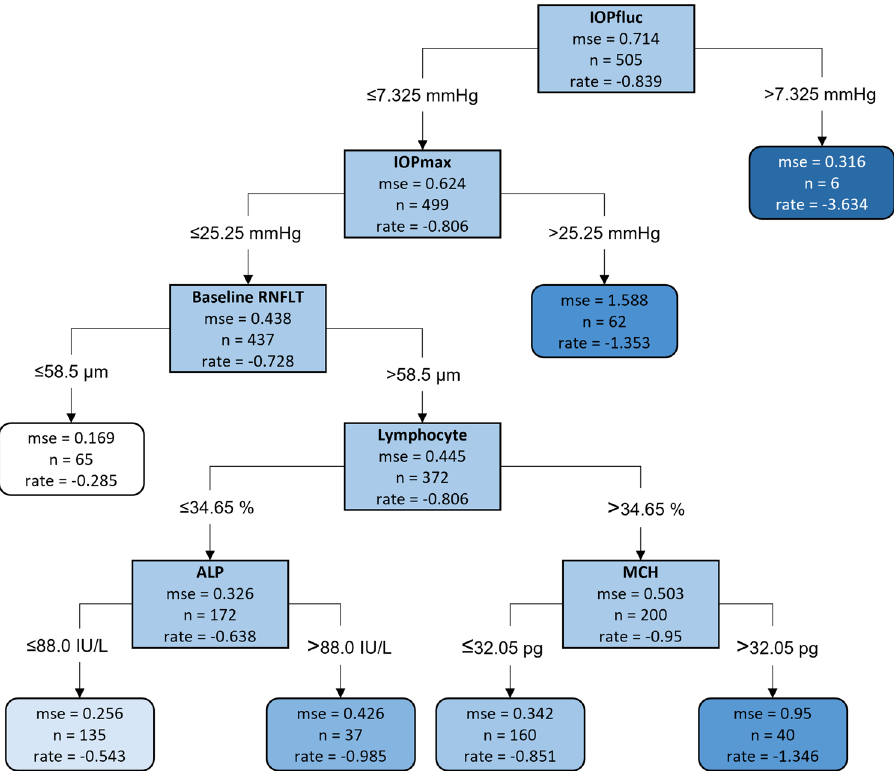
Figure 1. The decision tree model stratifying groups with faster or slower RNFL thinning based on the ophthalmic and systemic variables contributing to the rate of global RNFL thinning. The rate in each box indicates the rate of RNFL thinning in microns/year. IOPfluc IOP fluctuation during follow-up, mse mean squared error, IOPmax maximum IOP, RNFLT retinal nerve fiber layer thickness, ALP alkaline phosphatase, MCH mean corpuscular hemoglobin.